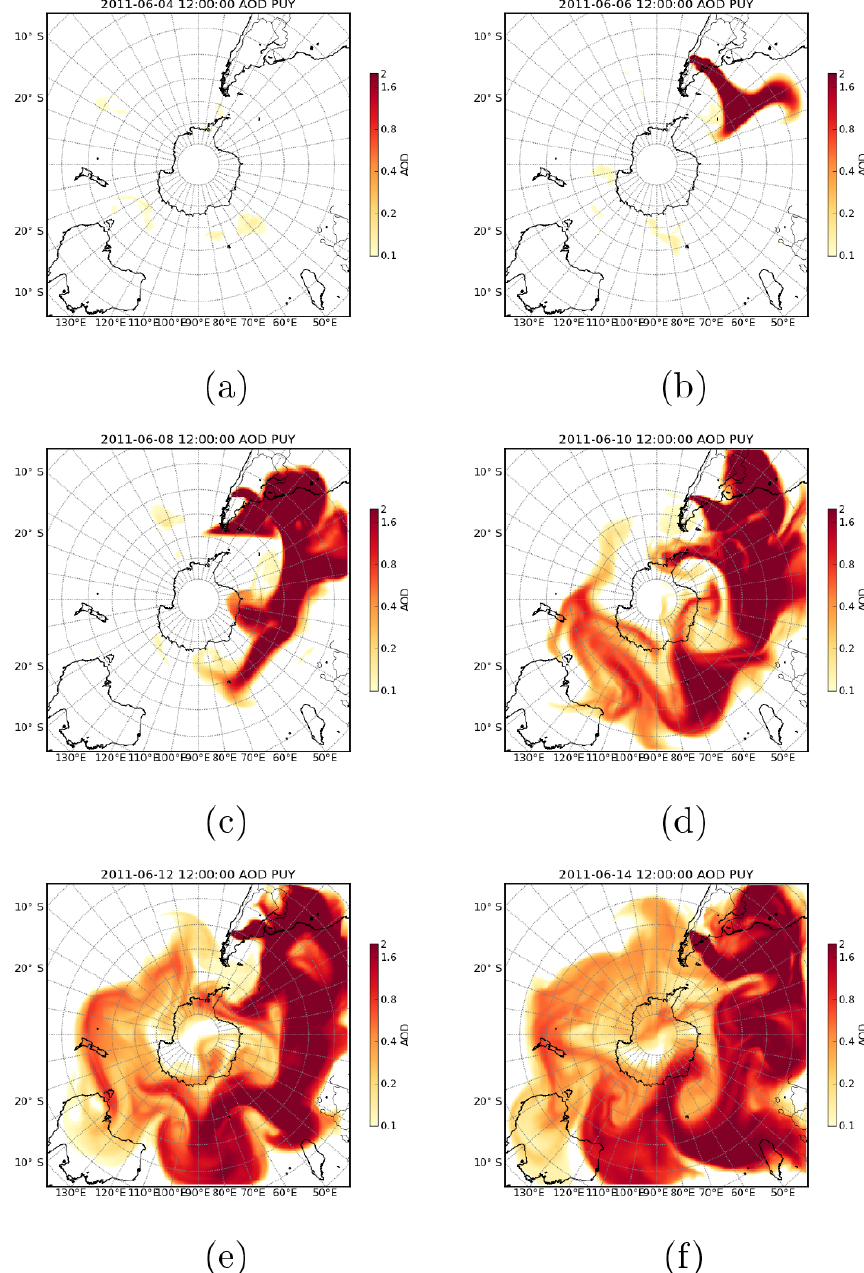
Figure 9. Simulated AOD at 600nm every 48h from 4 June, 12:00UTC to 14 June,